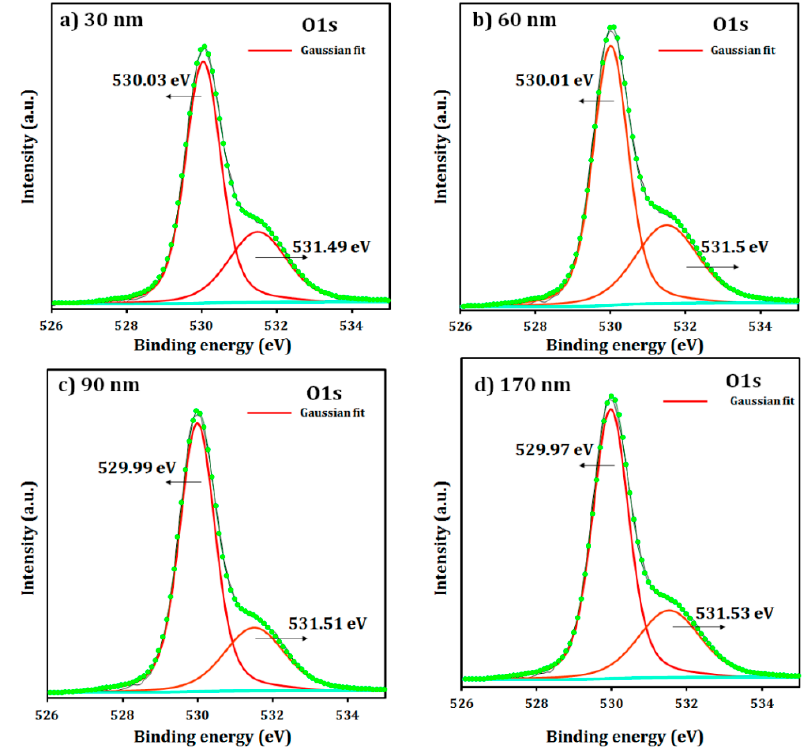
Figure 9. High resolution XPS spectra for the O1s peak of the SLG/i-ZnO films with different thicknesses in the region highlighted in green in Figure 7: ( a ) 30 nm, ( b ) 60 nm, ( c ) 90 nm, and ( d ) 170 nm.